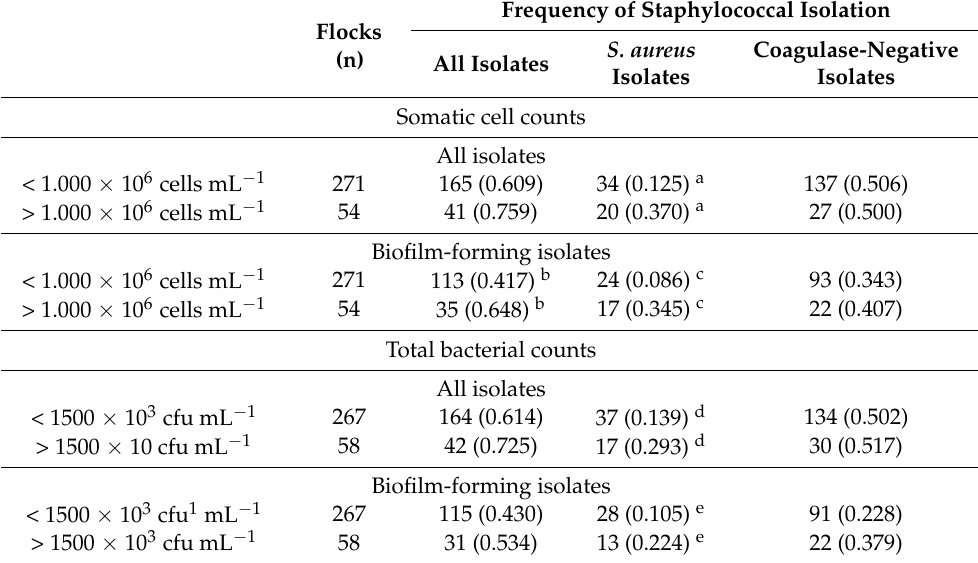
Table 2. Isolation of staphylococci from bulk-tank milk of 325 sheep flocks in Greece and association with somatic cell counts or total bacterial counts in the milk.